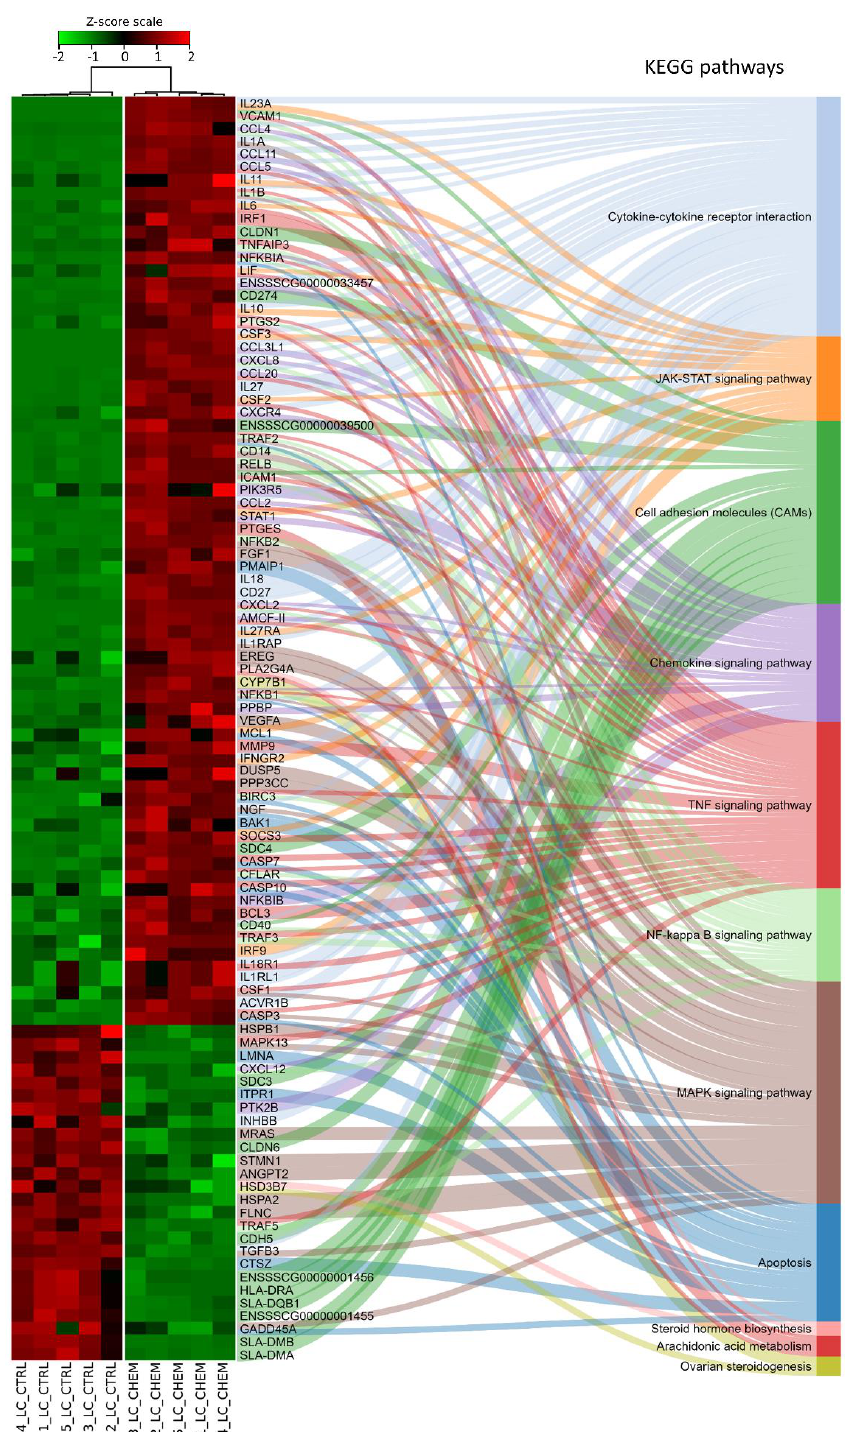
Figure 5. Heatmap of expression data for 98 di ff erentially expressed genes and their participation in metabolic pathways from the Kyoto Encyclopedia of Genes and Genomes (KEGG) database. Genes were ordered according to the dendrogram (not shown) of similarity of their expression profiles calculated on the basis of the respective Z-scores. Samples marked with CTRL belong to the control group, while CHEM were treated with